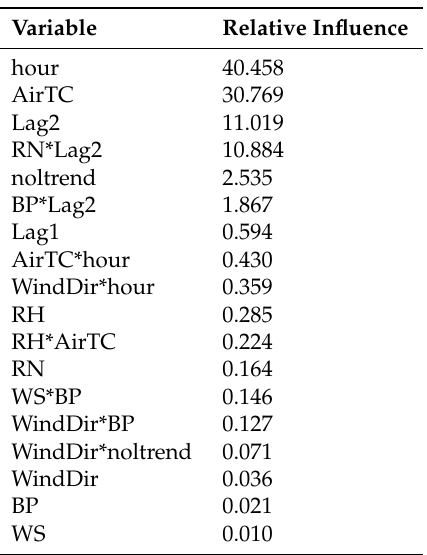
Table 3. Variable